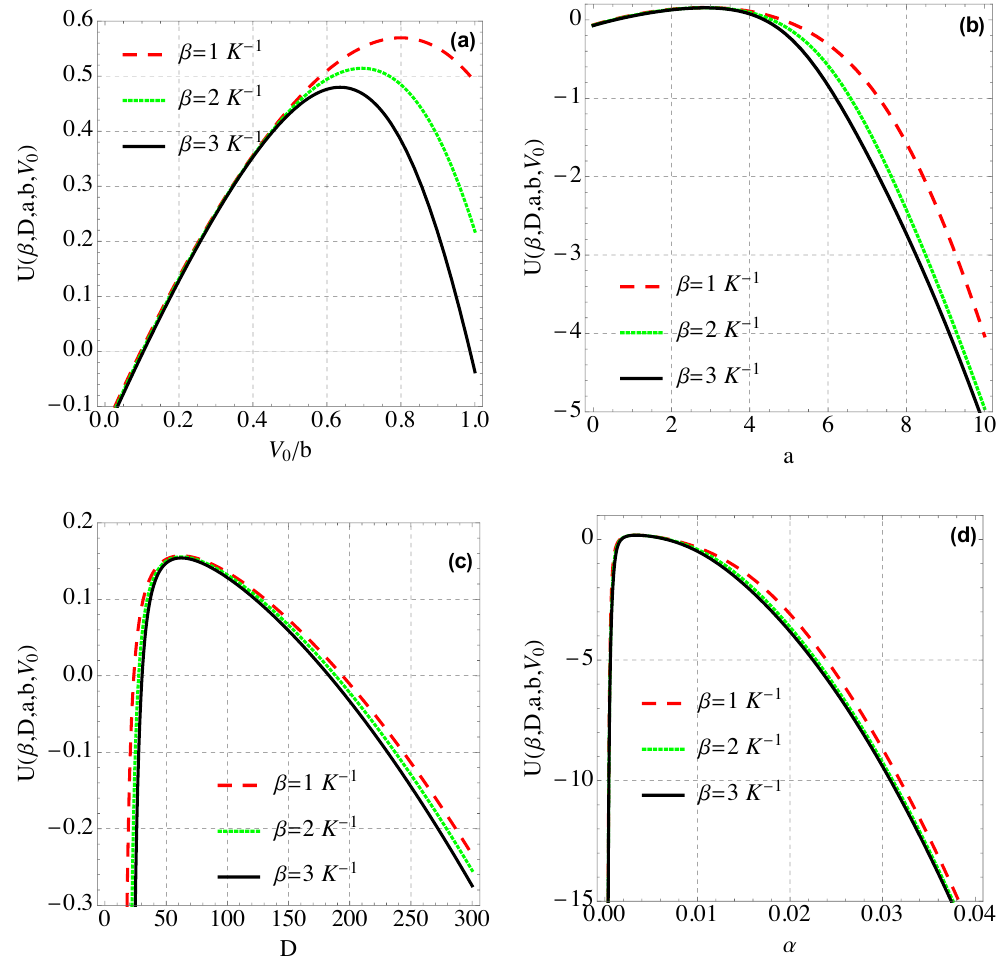
Figure 4. ( a ) Mean energy U ( β , D , a , b , V 0 ) as a function of V 0 / b , ( b ) parameter a , ( c ) D and ( d ) screening parameter α for β = 1.0K − 1 (red curve), 2.0K − 1 (green curve), and 3.0K − 1 (black